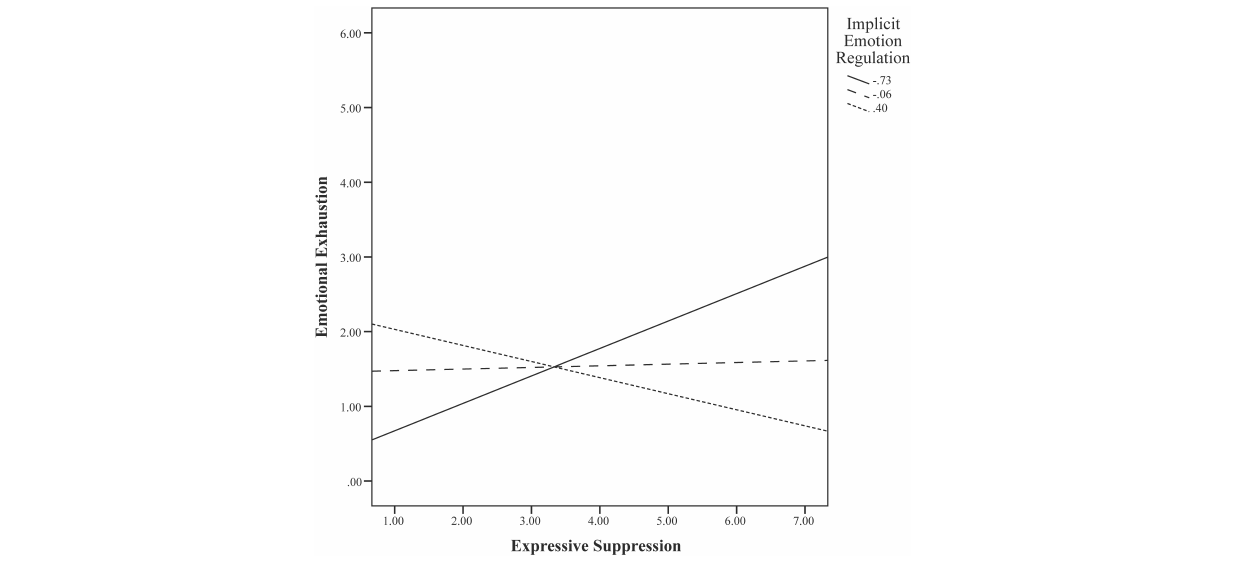
of emotional exhaustion and explored the moderating effect of implicit attitudes toward emotion regulation versus emotion expression on this association with an IAT. We included covariates that have been associated with teachers’ burnout level in previous studies (i.e., the teacher–student relationship, teaching experience, and gender). This study marks one of the first attempts to examine the potential moderating role of teachers’ implicit preferences on the relation between their typical use of emotion regulation strategies and their emotional